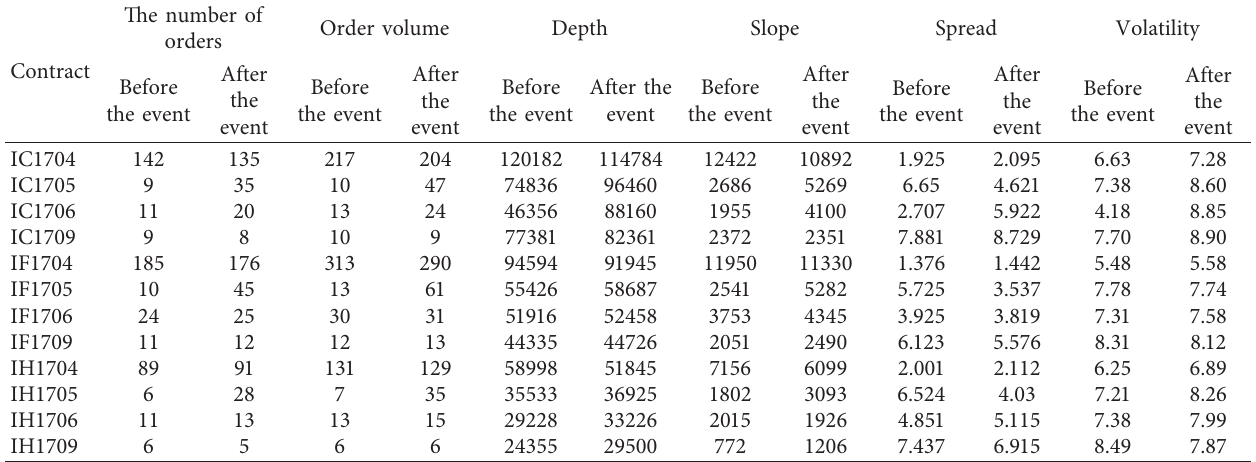
Table 2: Characteristics of LOB for IC, IF, and IH contracts before and after the